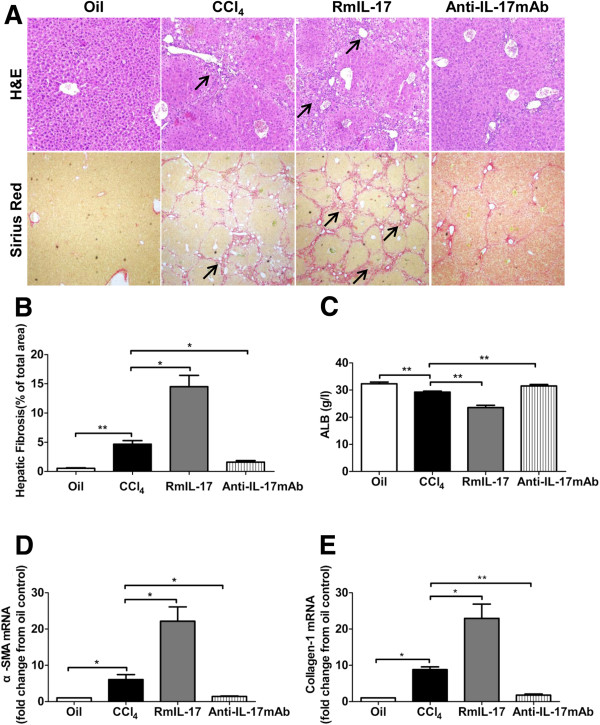
Key role of IL-17 in the pathogenesis of liver injury induced by CCl4 injection. Before CCl4 injection, mice were given monoclonal rat anti-mouse IL-17 antibody (anti-mouse IL-17 mAb) or recombinant mouse (rm) IL-17. (A) Liver inflammatory (upper panels arrowhead) and hepatic collagen deposition (lower panels arrowhead) were determined by H&E and Sirius red staining. Original magnifications: upper panels × 100, lower panels × 40. (B) The percentage of stained red area of Sirius red was assessed at 100 × magnification with a quantitative image analyzer. (C) Serum chemistry of liver function was performed for albumin (ALB). The expressions of alpha- smooth muscle actin (SMA) (D) and collagen-1 (E) mRNA in liver tissues were measured by real time (RT)-PCR. *p < 0.05, **p < 0.01.